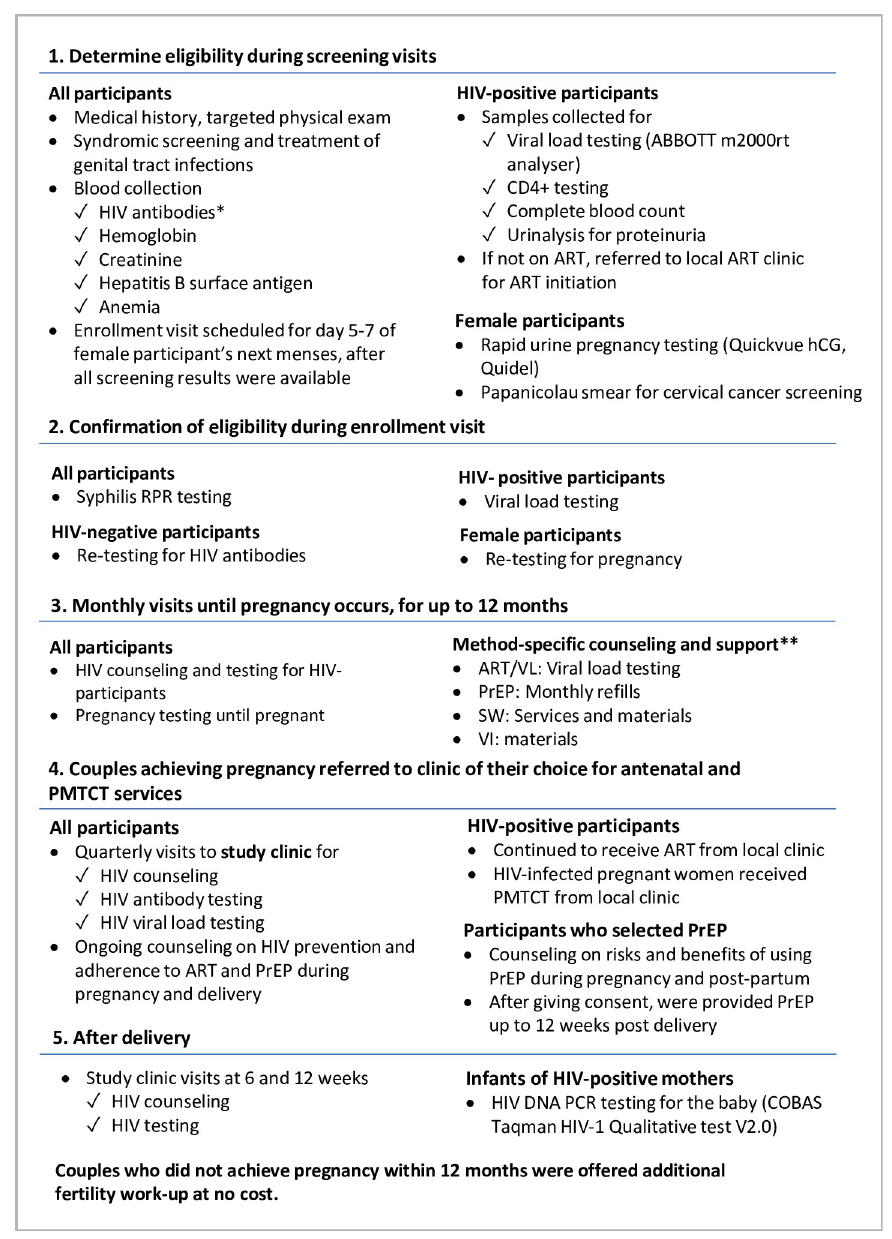
Fig 2. SAFER study procedures and clinical and laboratory work-up. � Using 3rd generation HIV rapid antibody tests, Determine HIV-1/2 and Oraquick, with confirmation of positives using 4th Generation BioRad GS HIV 1/2 COMBO EIA. �� See Fig 1 for additional details on each of the safer